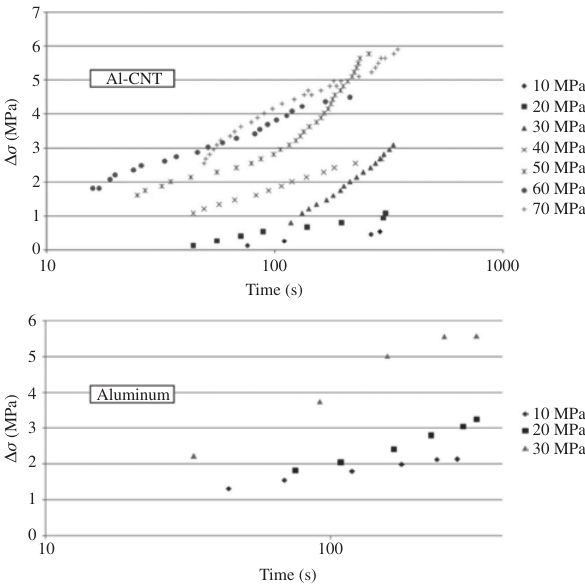
Figure 5: Graphs of stress relaxation data. Note that the time is plotted in logarithmic scale. The graphs have different initial stress ( σ ) values, which are written on the right margins of the o